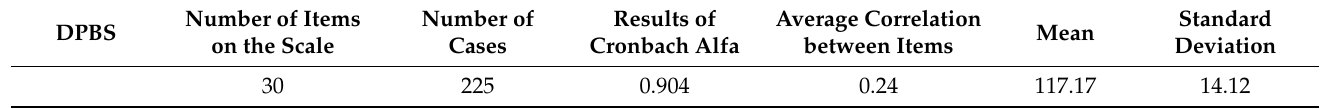
Table 7. Cronbach’s Alpha coefficient for the DPBS scale.